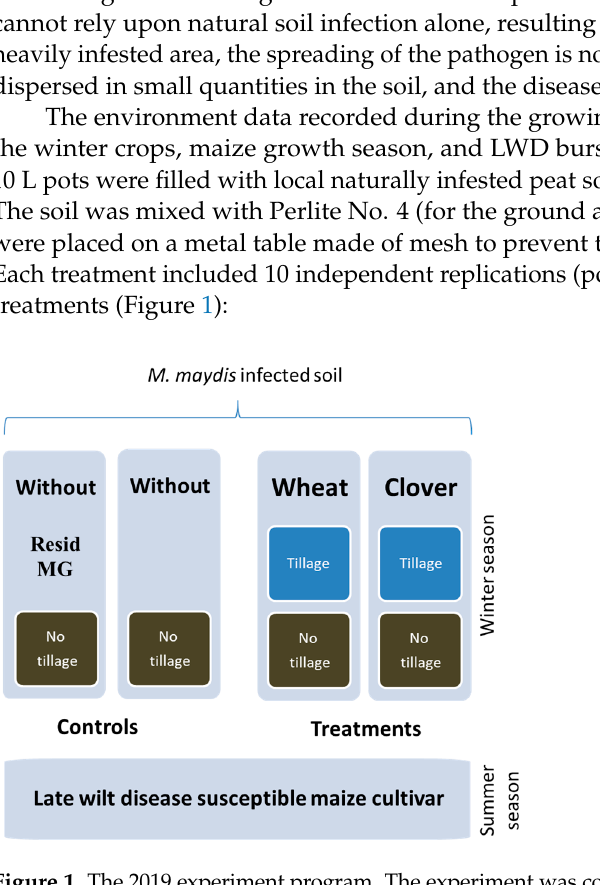
Figure 1. The 2019 experiment program. The experiment was conducted in pots in an open greenhouse over an entire growing season (winter season followed by spring–summer season). The late wilt susceptible maize genotype Prelude cv. was grown on M. maydis -infected soil in which wheat or clover had been grown as a crop prior to maize in this dual cultivation. The controls included the same prior crop soil but with tillage or soil that had not been cropped before the maize growth (control). Additionally, for comparison, the commercial Resid MG product of Arbuscular mycorrhizal, Glomus iranicum var. tenuihypharum (Symborg S.L., Murcia, Spain, supplied by BioBee Biological Systems, Sde Eliyahu, Israel) was tested as an addition to the soil that had not been cropped before growth.